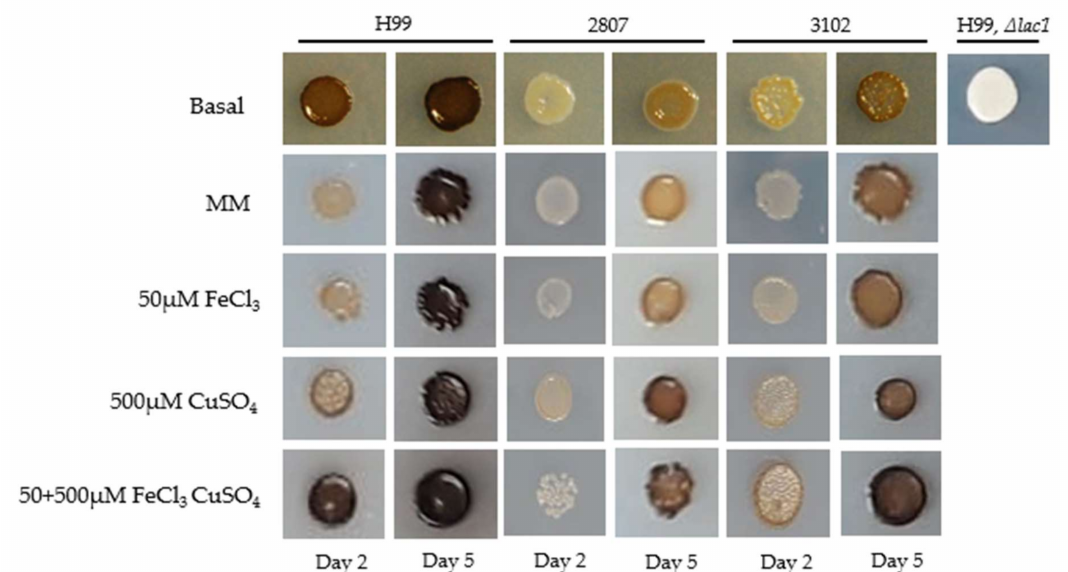
Figure 4. Melanin pigmentation of C. neoformans var. grubii (H99, 2807, and 3102) in L-DOPA medium. Different conditions were evaluated: SDB, MM (pre-incubation with MM without metals), 50 µ M iron, 500 µ M copper, and their combination (pre-incubation with the different concentrations of metals evaluated). The experiment was repeated on three different days, obtaining very similar